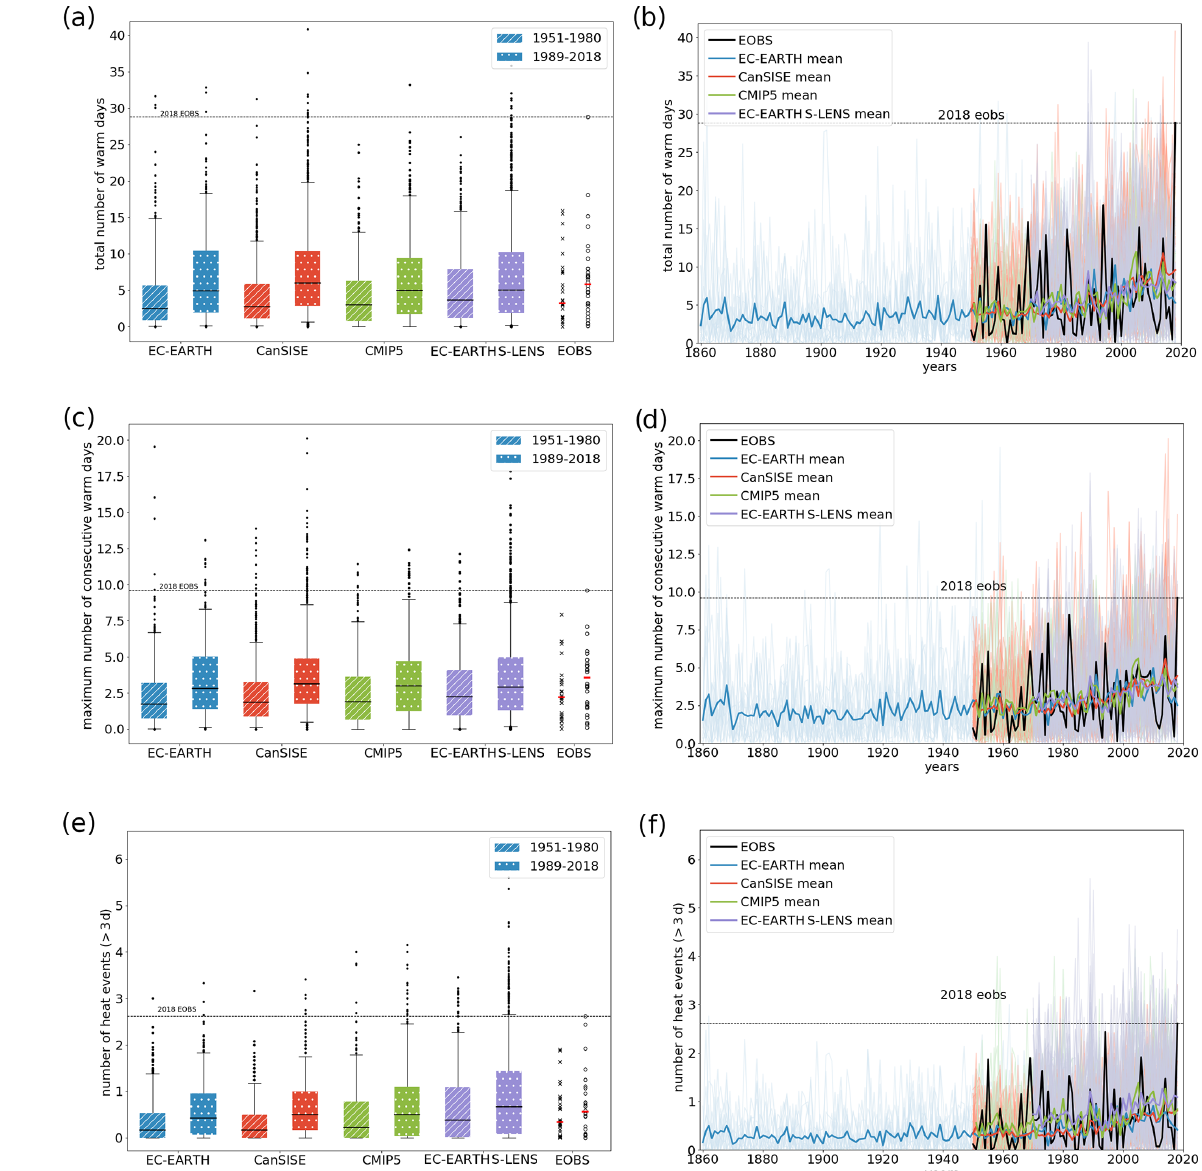
Figure 4. The left column shows (a) the total number of warm days (totWarmD), (c) the maximum number of consecutive warm days (max_conWarmD), and the (e) number of heat events (tot_events) for the 1951–1980 (dashed) and 1989–2018 (dotted) periods for four models ( x axis), calculated from the MJJA months and averaged over southern Sweden. All model members are pooled into one box. Corresponding data for E-OBS are shown to the right with the red mark indicating the median. The right column shows time series for each ensemble member (thin lines) and ensemble means (bold lines) for (b) totWarmD, (d) max_conWarmD, and (f) tot_event. The number of days for 2018 as derived from E-OBS is indicated by the horizontal dashed